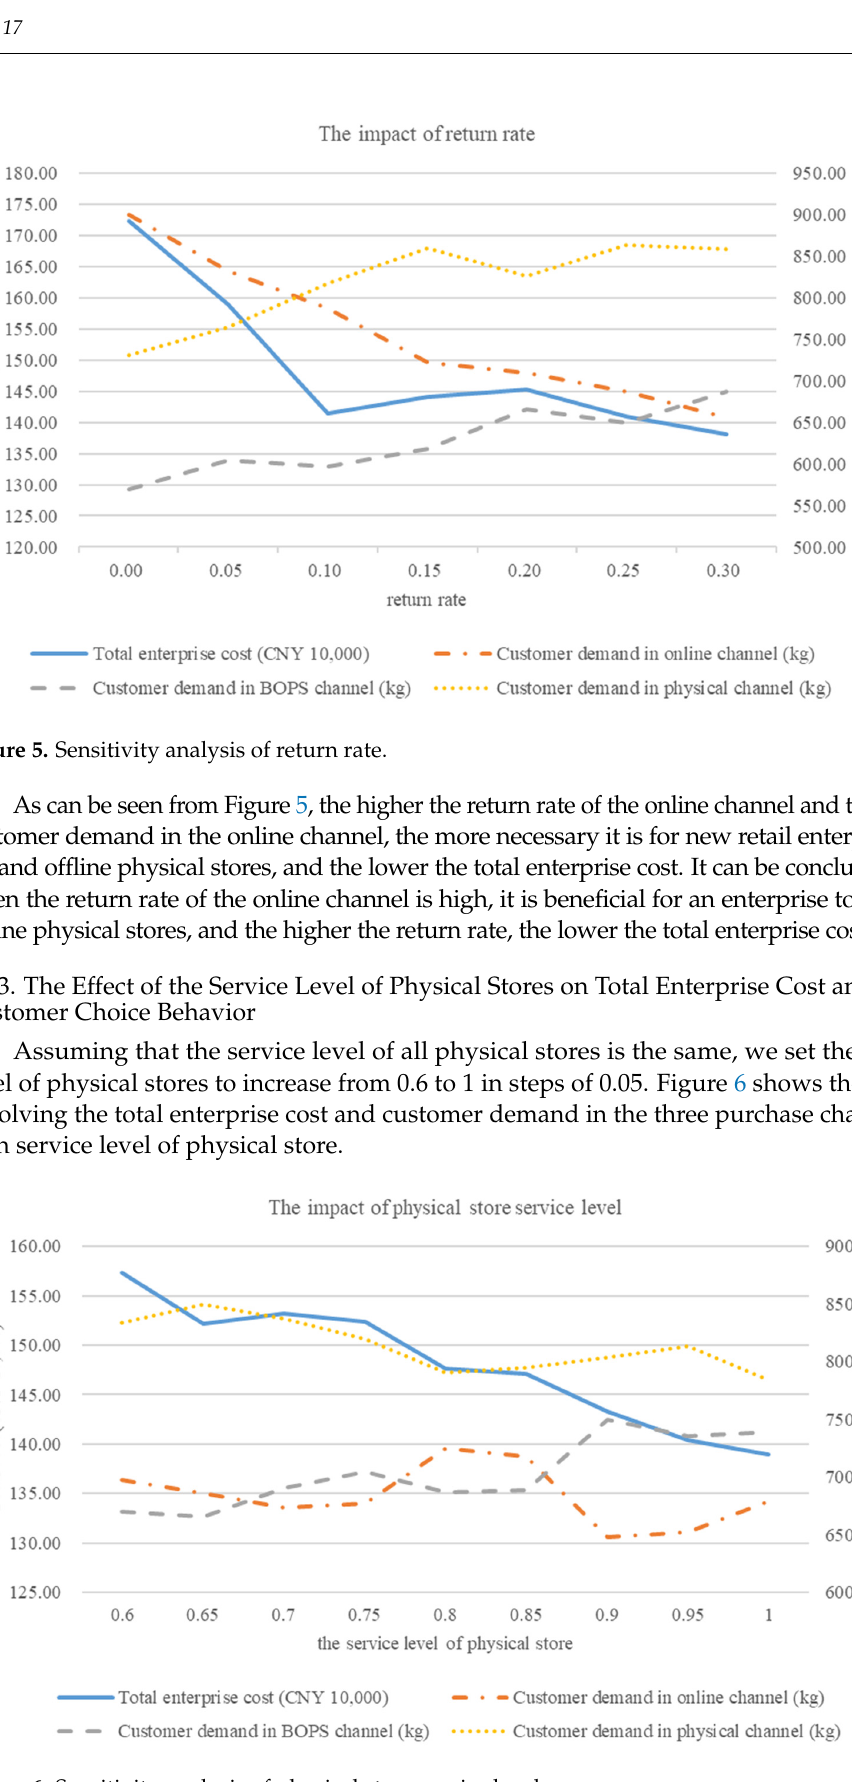
Figure 6. Sensitivity analysis of physical store service level.